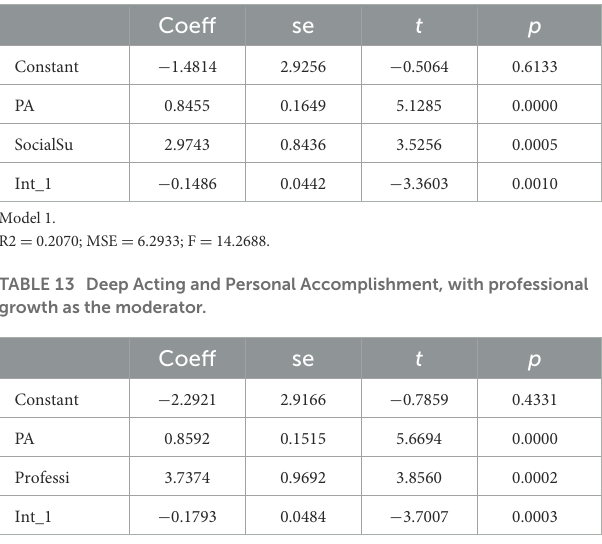
TABLE 12 Deep Acting And Personal Accomplishment, with social support as the moderator.